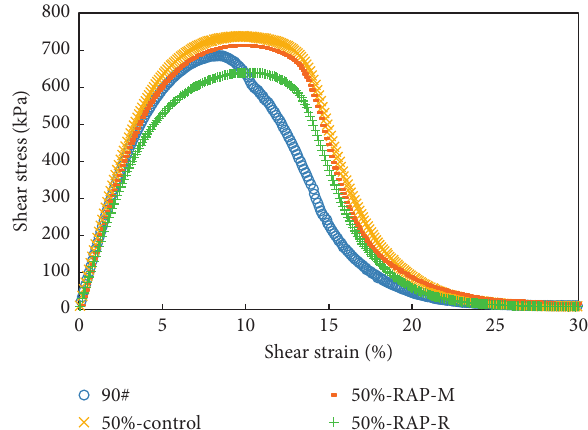
Figure 22: Shear stress and phase angle of LAS test.